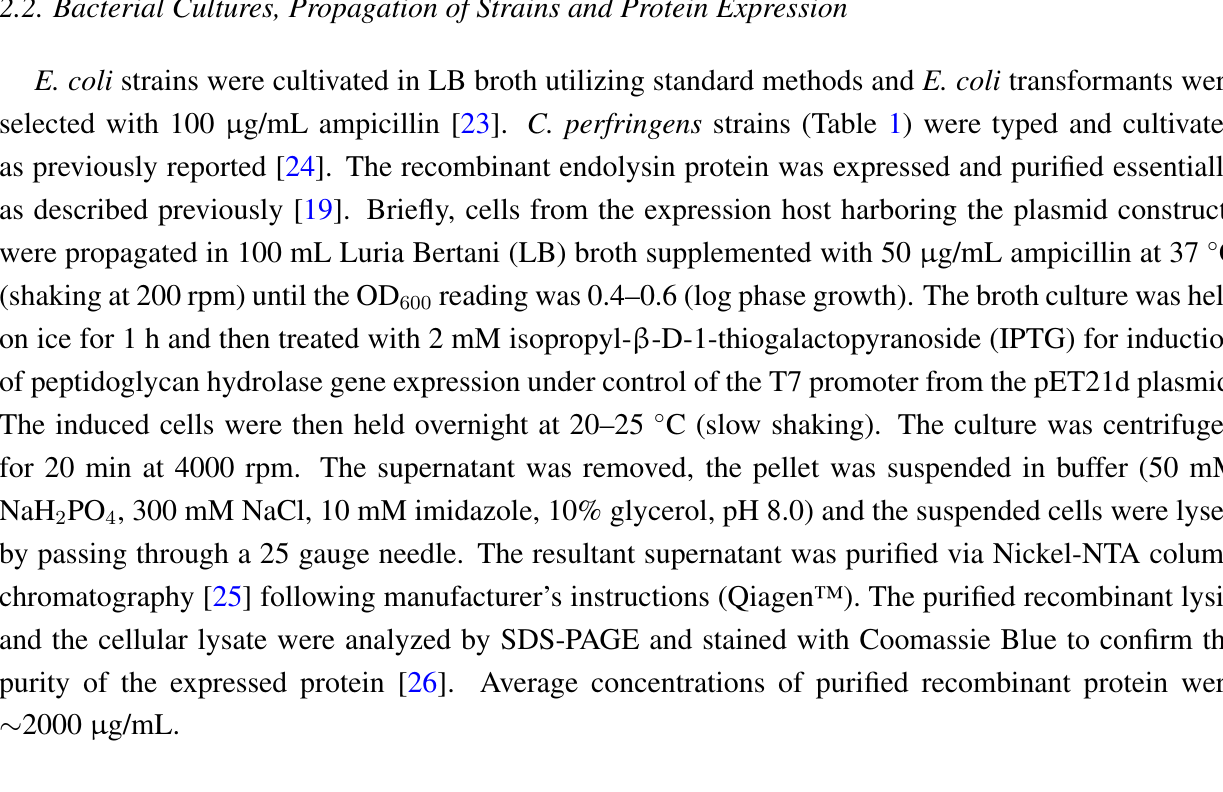
Figure 1. Schematic representation of the recombinant constructs and sodium dodecyl sulfate polyacrylamide gel electrophoresis (SDS-PAGE)analysis of purified proteins. ( A ) Schematic of the recombinant phage endolysins used in this report. The fusion construct PlyGVE2CpCWB consists of the amidase domain from the PlyGVE2 endolysin (light grey) and the cell-wall binding (CWB) domain of the PlyCP26F endolysin (dark grey); ( B ) Representative 15% SDS-PAGE of the endolysin constructs. Lane 1. PlyGVE2CpCWB, Lane 2. PlyCP26F, and Lane 3. PlyCP39O, M = markers (Precision Protein Plus, Biorad). All proteins are nickel column purified at >95% purity and the purified protein full length amino acid sequence was further verified by mass spectrometry (See Supplementary Information).